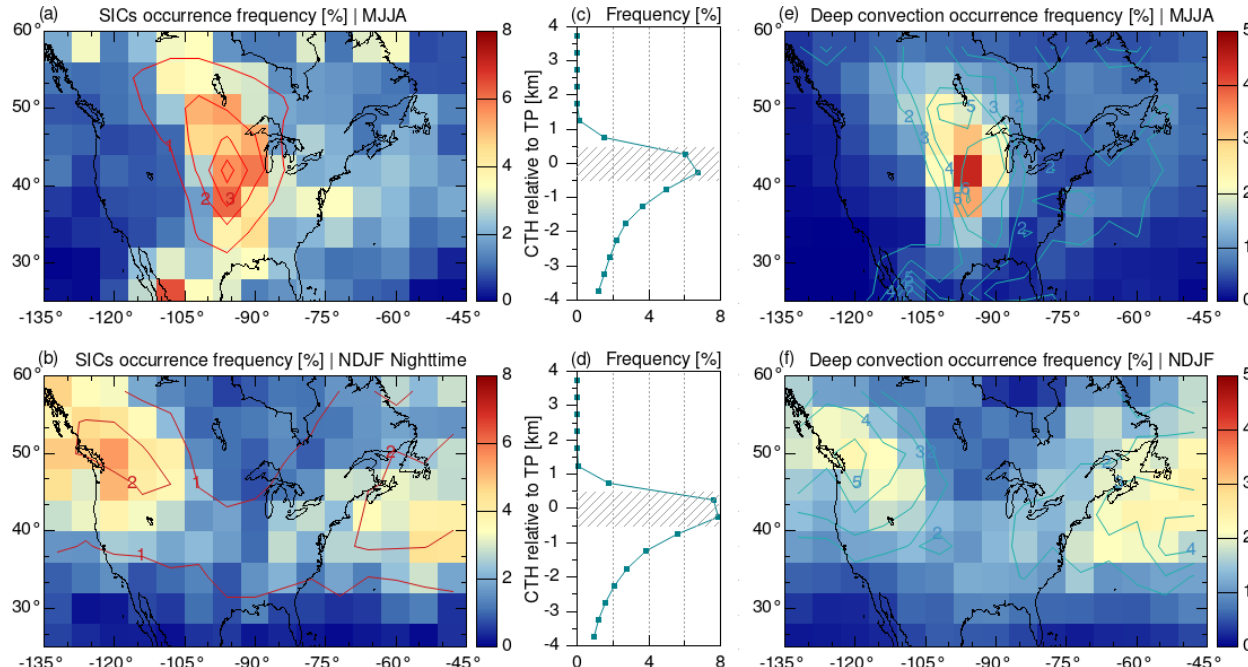
Figure 2. Nighttime seasonal mean occurrence frequencies of SIC from 2006 to 2018 in (a) MJJA and (b) NDJF on a 4 ◦ × 6 ◦ (lati- tude × longitude) grid size. SICs detected by CALIPSO are cirrus clouds that have a cloud top height at least 500m above the tropopause derived from ERA-Interim. Panels (c) and (d) are the corresponding occurrence frequencies of ice cloud top heights in the altitude range from − 4 to 4km with respect to the tropopause over North America. Occurrence frequencies of deep convection are shown in (e) MJJA and (f) NDJF. Deep-convection events measured by AIRS are defined as a difference between the 8.1µm brightness temperature and the ERA-Interim tropopause temperature below 7K. The red contour lines in (a) and (b) show the occurrence frequencies of deep convection, and blue contour lines in (e) and (f) are occurrence frequencies of